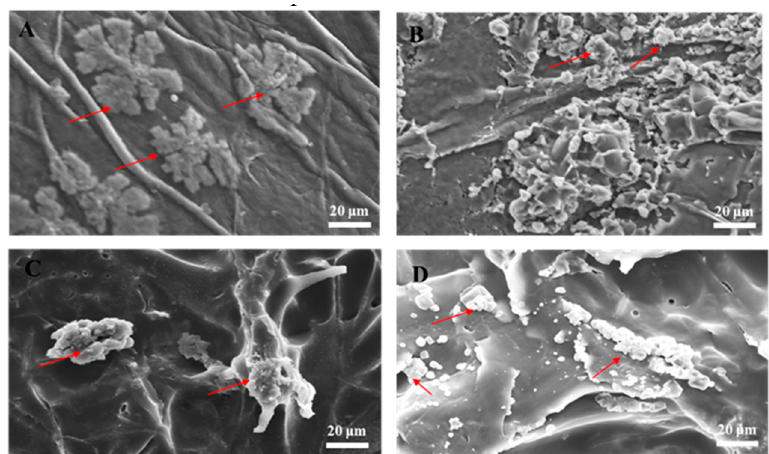
Figure 3. SEM images of human adipose stem cells line (hASCs) grown on biomaterials for 7 d. ( A ) BC scaffold, ( B ) BC/RSV scaffold, ( C ) COL scaffold, and ( D ) COL/RSV scaffold. Red arrows indicate